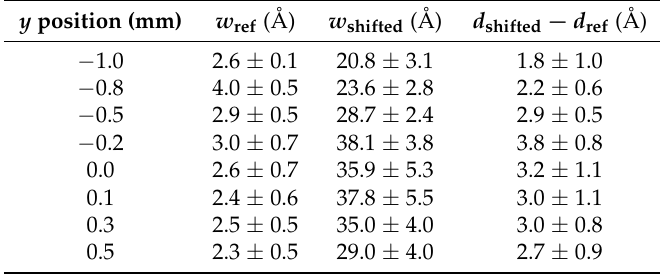
Table 1. Summary of the experimental data.